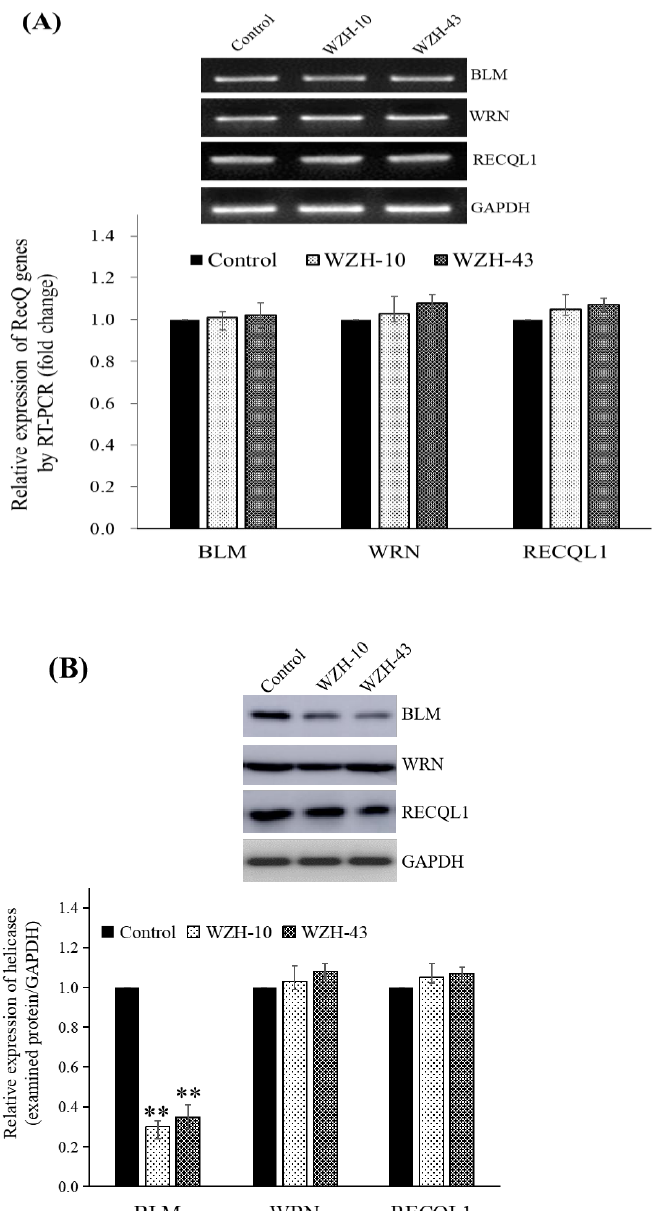
Figure 4. Effect of the two prenylated chalcones on the expression of BLM helicase in PC3 cells. ( A ) Expression of the BLM gene in PC3 cells after the treatment with the two agents. ( B ) BLM helicase protein expression in PC3 cells by Western blotting. Cells were treated with 1.0 µM WZH-43 and 0.1 µM WZH-10 for 48 h. The results were normalized to the expression of GAPDH, and the fold change was relative to PC3 cells incubated in medium alone (time matched). Results are presented as mean ± SEM. ** p < 0.01 ( n = 3) compared with the control.